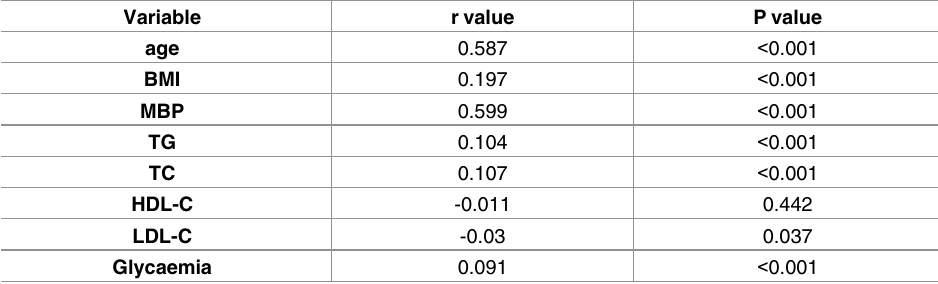
Table 2. Spearman correlation analysis on brachial-ankle pulse wave velocity (baPWV).